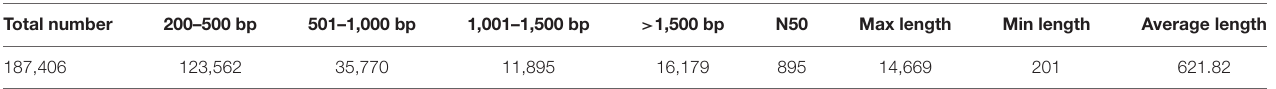
TABLE 2 | Statistical results of transcriptome